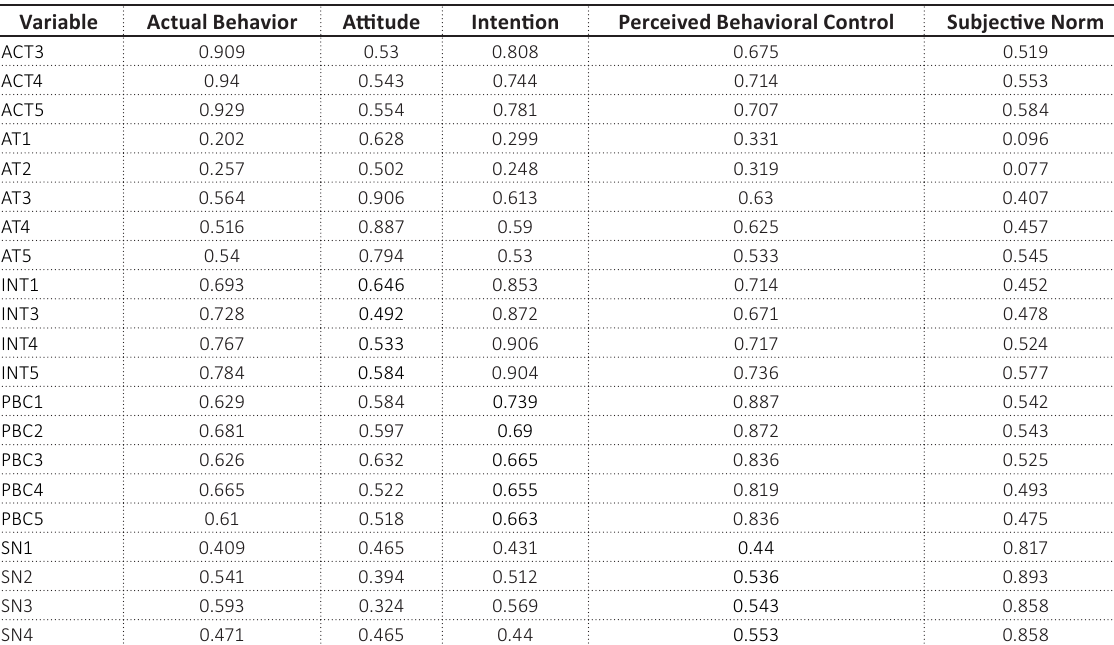
Table 4. Cross-loadings